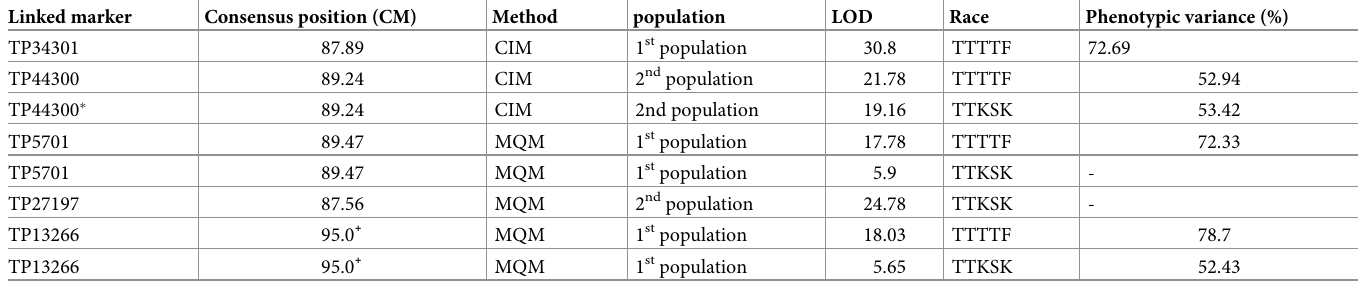
Table 1. QTL detected for resistance to two Pgt races on chromosome 2U with two populations of Ae umbellulata with composite interval (CIM) and multiple QTL mapping methods (MQM). Linked